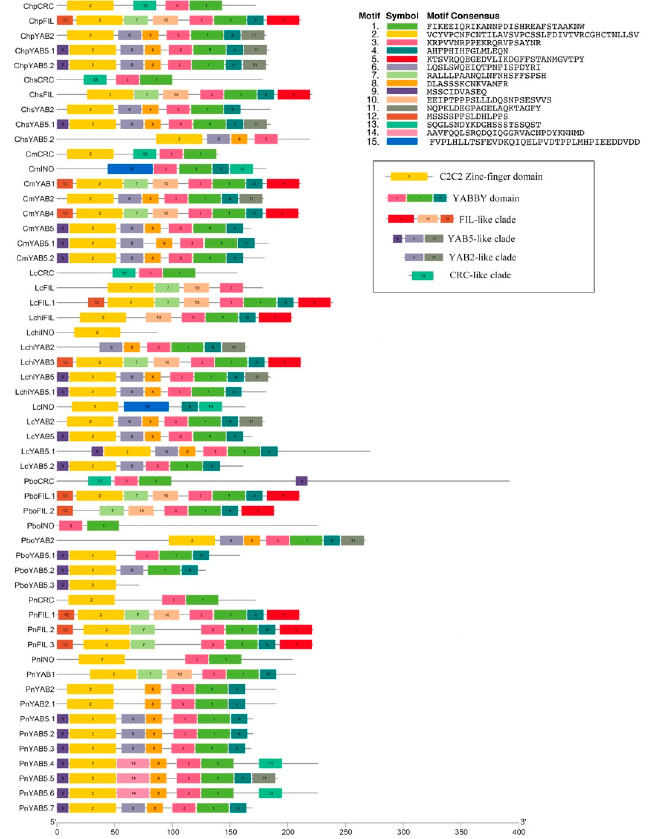
Figure 2. Conserved motifs analysis in YABBY proteins among seven magnoliids. Motifs were determined using MEME suite version 5.1.1. Black lines represent the non-conserved sequence, and each motif is indicated by a colored box numbered in the middle. The same acronym represents the same species: Cm: C. micranthum ; Chp: C. praecox ; Lc: L. cubeba ; Chs: C. salicifolius; Pbo: P. bournei ;